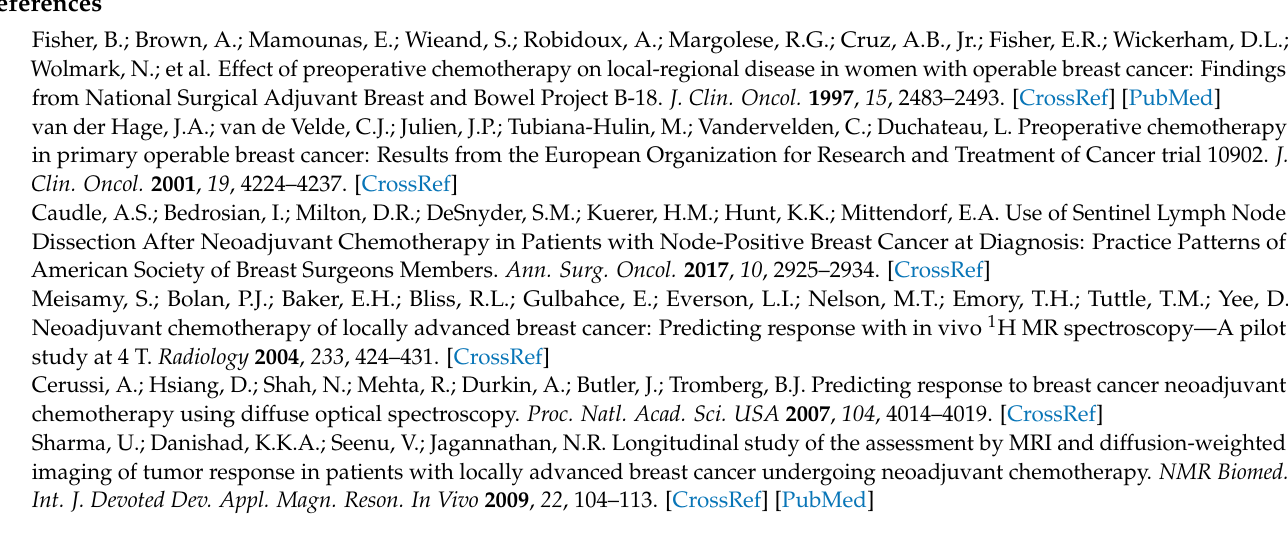
BC (TNBC) subtype ( n = 21), the averages of the plasma proteomic abundance data in the pCR group ( n = 8) were compared with the averages of the data for the non-pCR group ( n = 13) with TNBC. The red circle shows four plasma proteins showing significant increases in the non-pCR group. The green circle shows two plasma proteins with significant decreases in the non-pCR group. Gray circles are plasma proteins with no statistical significance. Figure S4: Kaplan–Meier plots of pCR in relation to three proteins (MBL2, ENG, and P4HB) against overall survival (A) and distant metastasis- free survival (B). Figure S5: Kaplan-Meier plots of Miller–Payne grades in disease-free survival (A), distant meta-free survival (B), and overall survival (C). Statistical significance was determined using the log-rank test. p -values < 0.05 are displayed in bold. Table S1. Demographic and clinical characteristics of the 51 breast cancer patients with or without pCR. Table S2. Normalized abundance of 305 plasma proteins in 51 breast patients with or without pCR. Table S3. Results of volcano plot analysis between the pCR group and the non-pCR group. Table S4. Selected feature proteins by AUC-based RF backward elimination with 305 proteins as input. Table S5. Univariate survival analysis of recurrence, metastasis, and death. Table S6. Association between three biomarkers with clinical and pathological